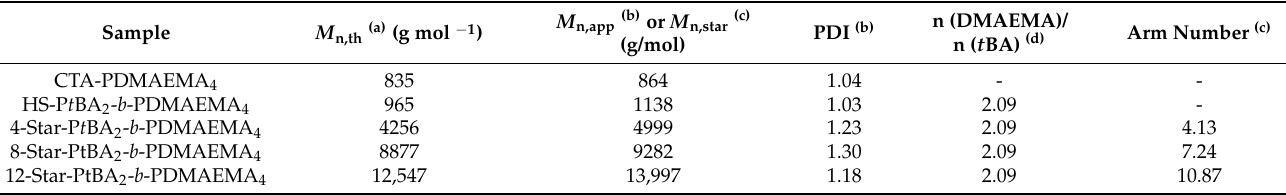
Table 1. Molecular weights and PDI of chain polymers and star-like block copolymers.